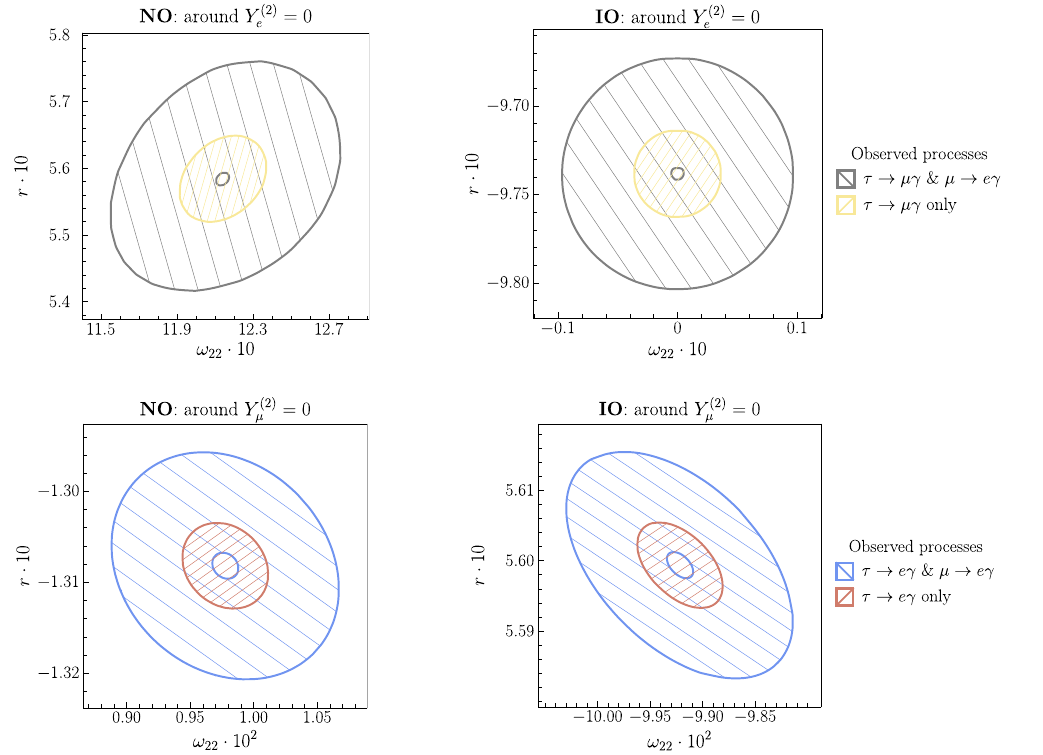
Figure 7. Regions in the ω 22 − r plane where the observation of the listed processes is possible in the planned experiments. For example, the gray dashed regions in the upper plots correspond to the case, where τ µγ and µ eγ are observed simultaneously, the yellow dashed region shows → → the allowed values when only τ µγ is observed, but µ eγ not, as noted in the plot legend. → → Note, that the top-left area is significantly larger than other